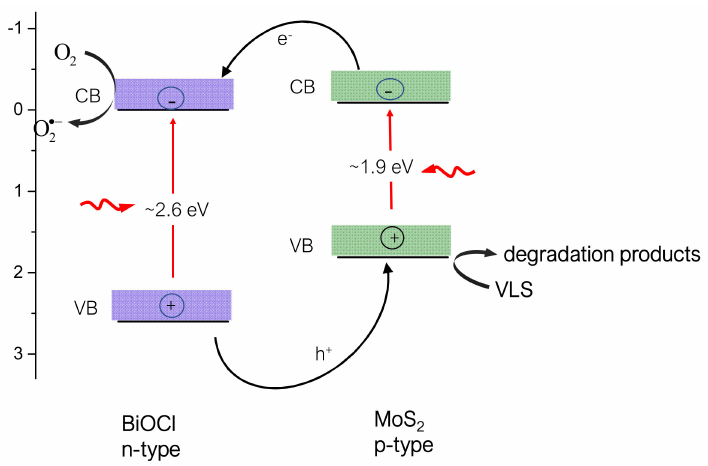
Scheme 1. Simplified diagram showing the relative band edge positions and charge separation in irradiated MoS 2 /BiOCl